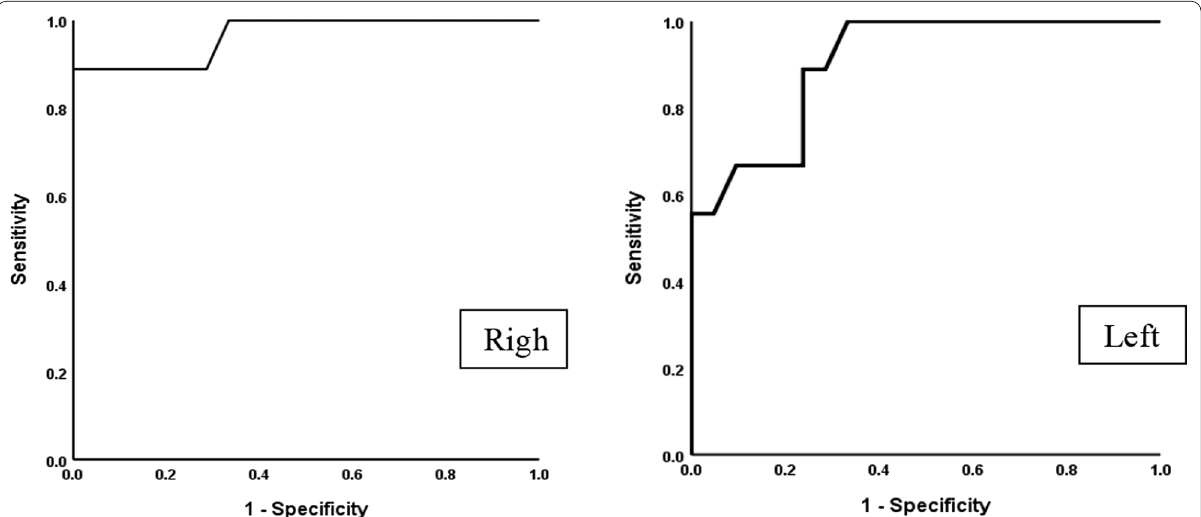
Fig. 1 ROC curve analysis to explore the discriminant ability of SWE to determine DPN in the right and left lower